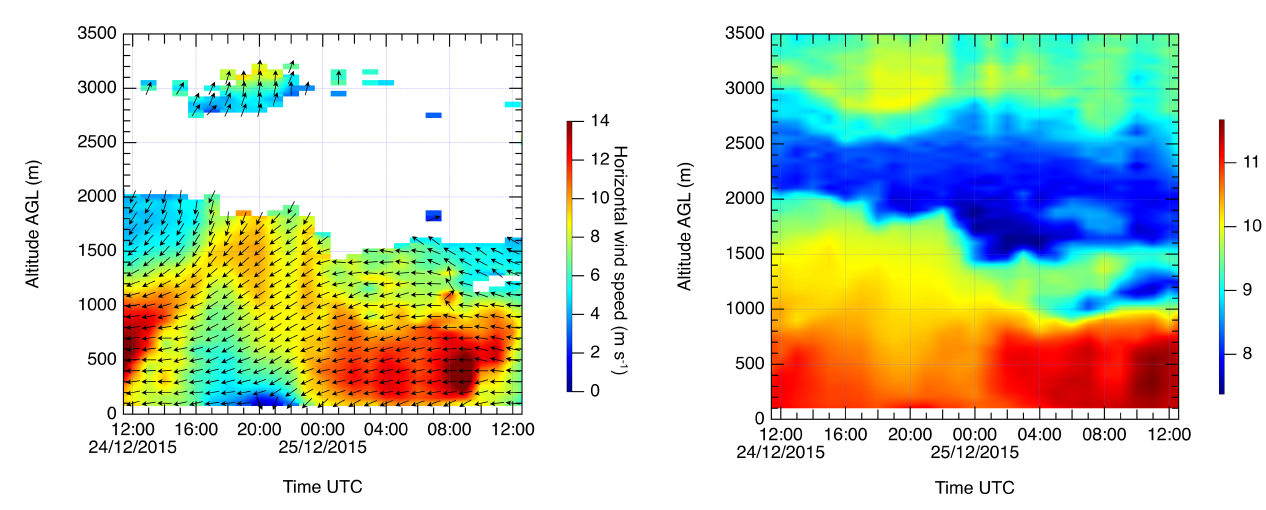
Figure 4. Time–height section of horizontal wind direction (arrows) and wind speed (color map) deduced from Doppler lidar during 24– 25 December 2015. Leftward and downward arrows represent, re- spectively, easterly wind and northerly wind.